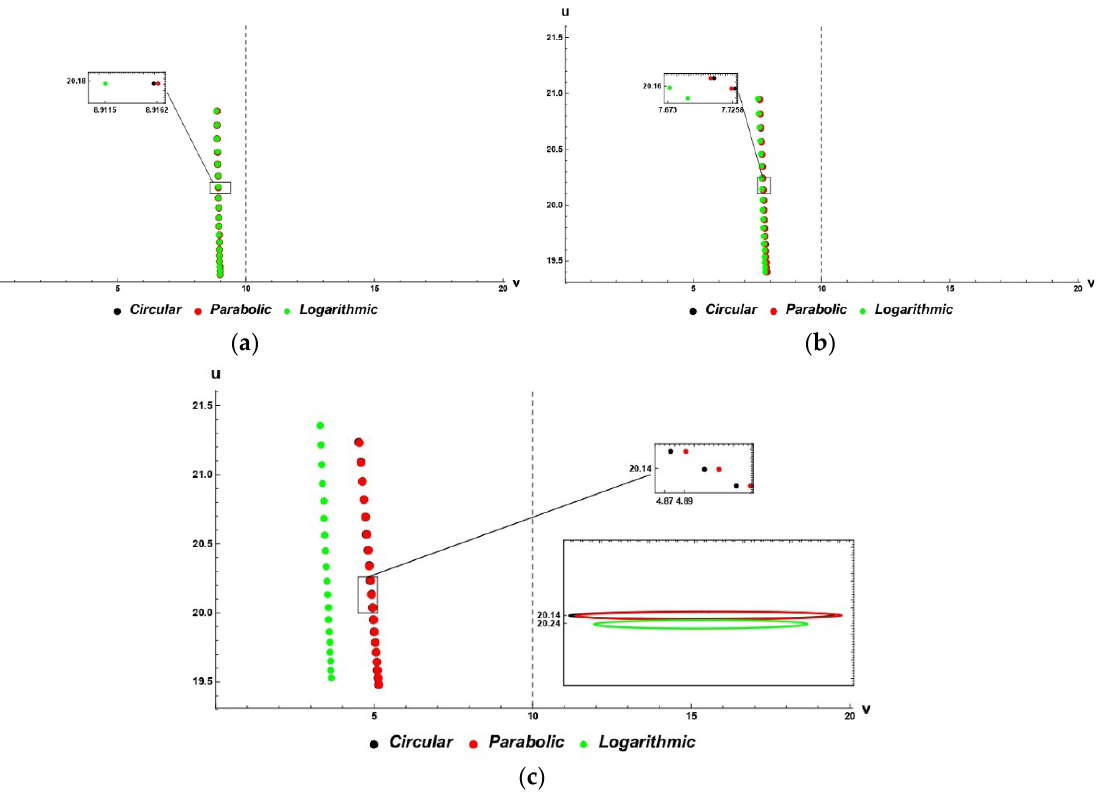
Figure 21. Path of contact of longitude circular, parabolic, and logarithmic crowned helical gear with out-of-plane misalignment: ( a ) 0.05 ◦ (0.87 mrad), ( b ) 0.1 ◦ (1.7 mrad), and ( c ) 0.2 ◦ (3.5 mrad). The dashed line indicates the center of the tooth surface along the width of the gear. The scaled contact ellipses at the pitch point are shown at the 0.2 ◦ misalignment angle.